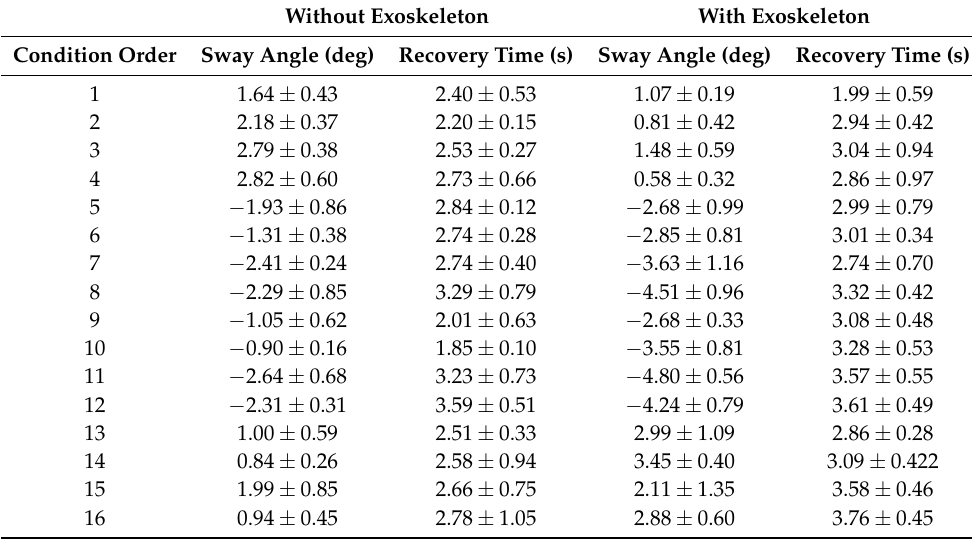
Table A1. Mean and standard deviation of the calculated BIs considering the five good repetitions within each condition of the protocol. Two scenarios were tested: participant not wearing and wearing the exoskeleton.